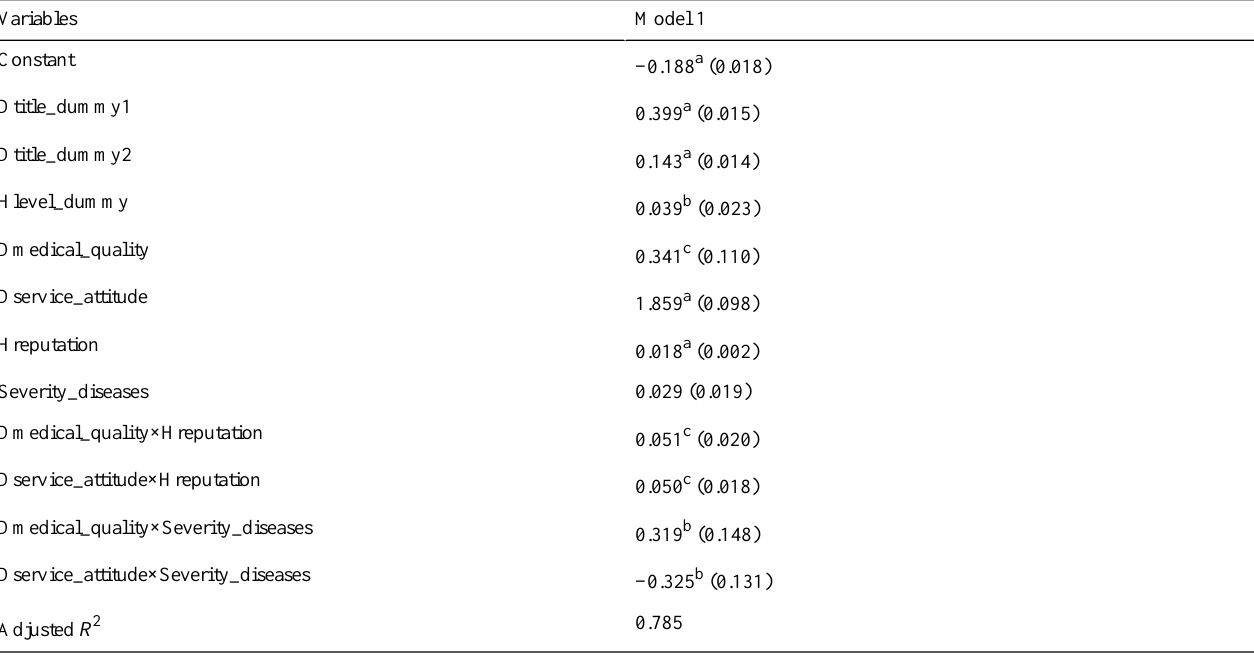
Table 4. Results for the increment of outpatient care service demands. Ordinary least squares regression was used to obtain